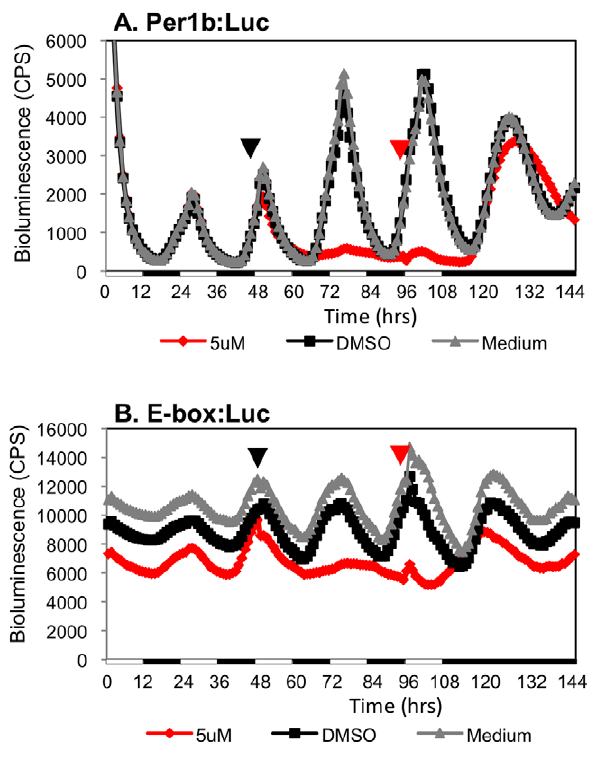
Figure 2. The effect of CK1 d -inhibition on peripheral circadian clocks is reversible. Bioluminescence assay of cells transfected with per1b:Luc (A) and Ebox:Luc (B). Cells were maintained under LD cycles, and then the inhibitor, PF-670462 (5 m M), was added to the cell culture 1.5 h before lights on (black arrows). Cells were maintained in LD conditions for 2 days after which the inhibitor was washed away 3.5 h before lights on (red arrows). After one LD cycle for re-entrainment, the cells were transferred to constant darkness for 24 h. Control cells were treated with DMSO. Bioluminescence is plotted on the y-axis and time (hours) on the x-axis. White/black bars show the light and dark periods, respectively. The clock-controlled rhythmic promoter activity reap- peared immediately following removal of the inhibitor. Thus the effects of CK1 d inhibition are reversible.